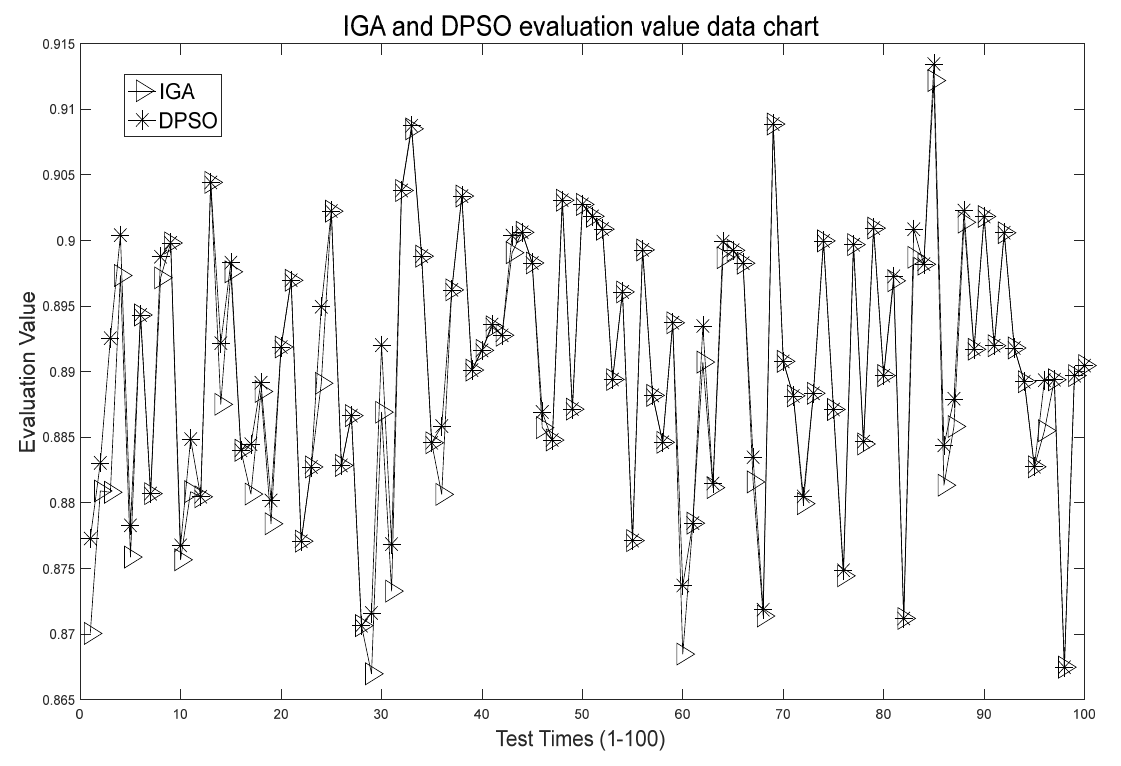
Figure 5. Two-algorithm evaluation-value comparison chart of 100 tests.